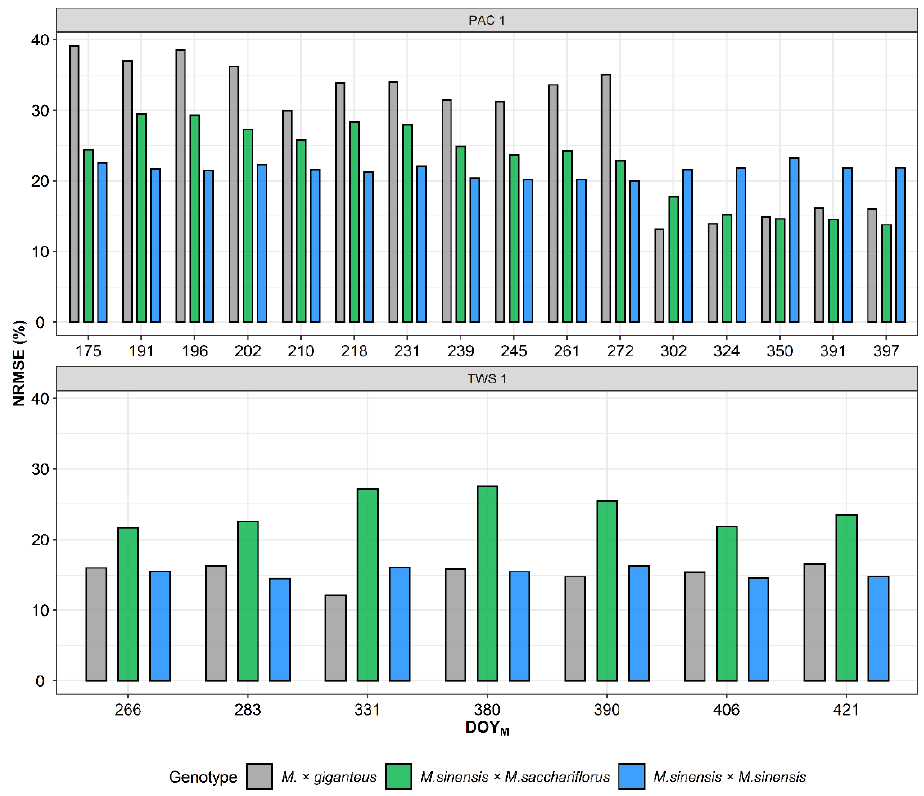
Figure 11. NRMSE values of the RF model for yield prediction trained with the peak of the VIs, derived from the complete time series and tested with the peak of the VIs derived from the partial time series fitted until the modified days of the year (DOY M ) of the UAV flight, at the two locations PAC 1 and TWS 1.